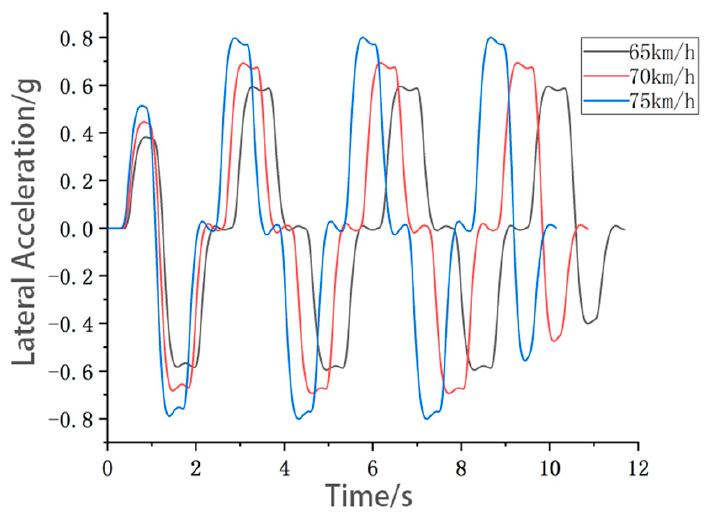
Figure 12. Simulation curve of lateral acceleration without crosswind effect.